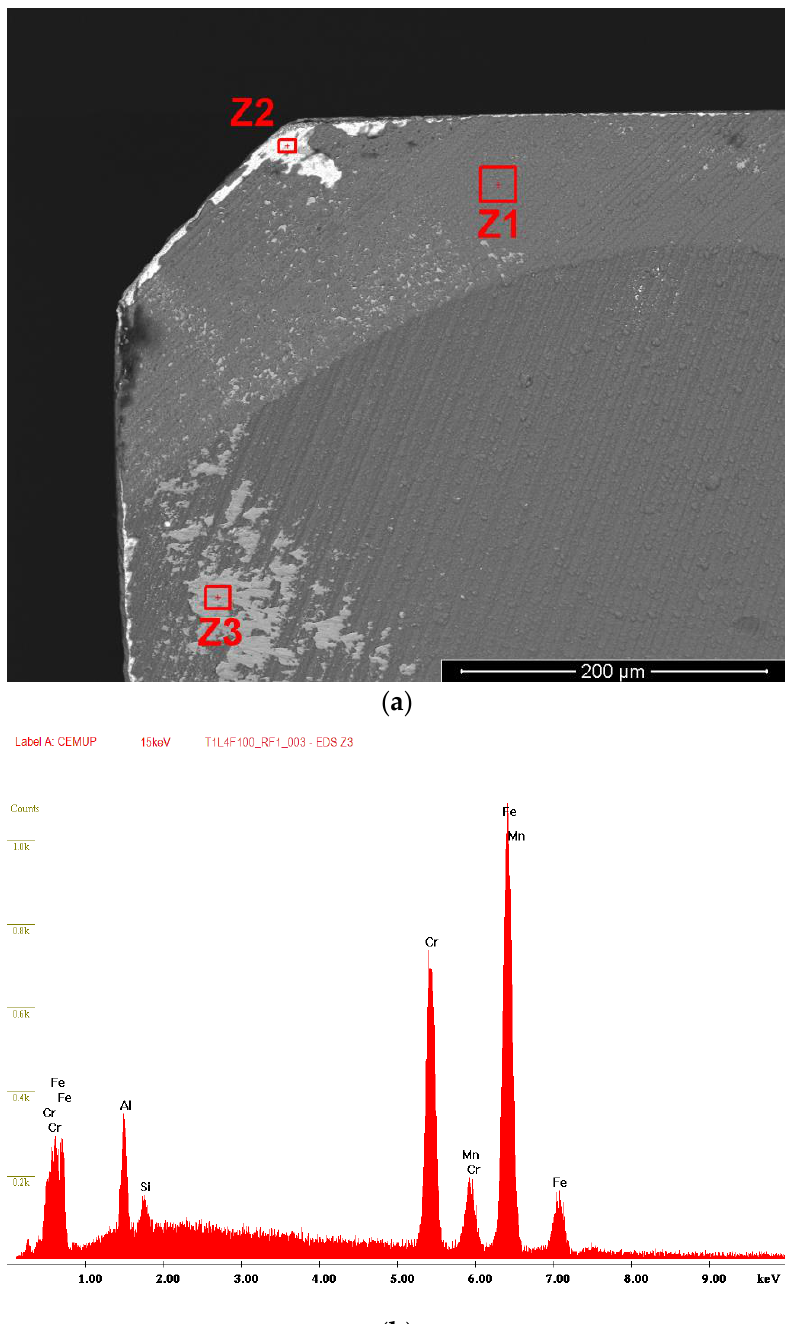
Figure 6. Rake face of the T1L4F100 tool with the various zones picked for analysis ( a ), and analysis of zone 3 (Z3), where there are signs of adhesion ( b ).